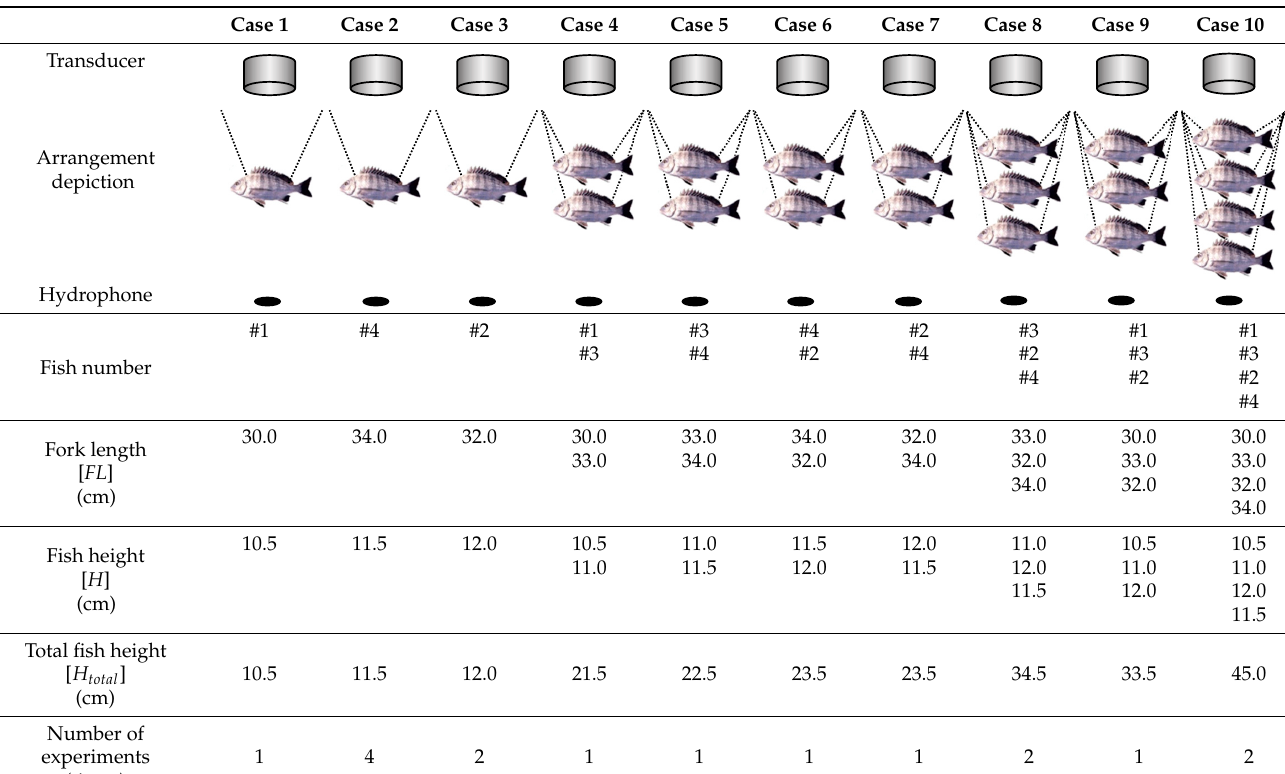
Table 2. Details of the experimental cases of the arrangement depiction, fork length, height, total fish height, and the number of experiments.